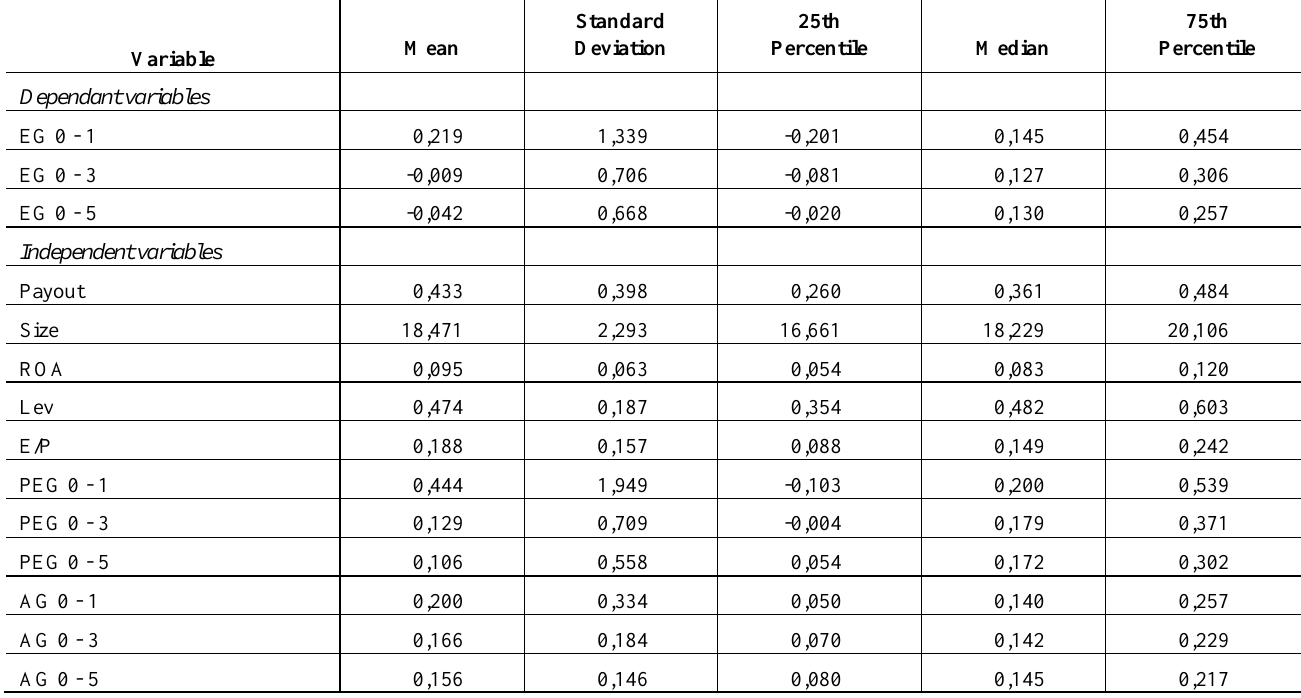
Table 2: Descriptive statistics